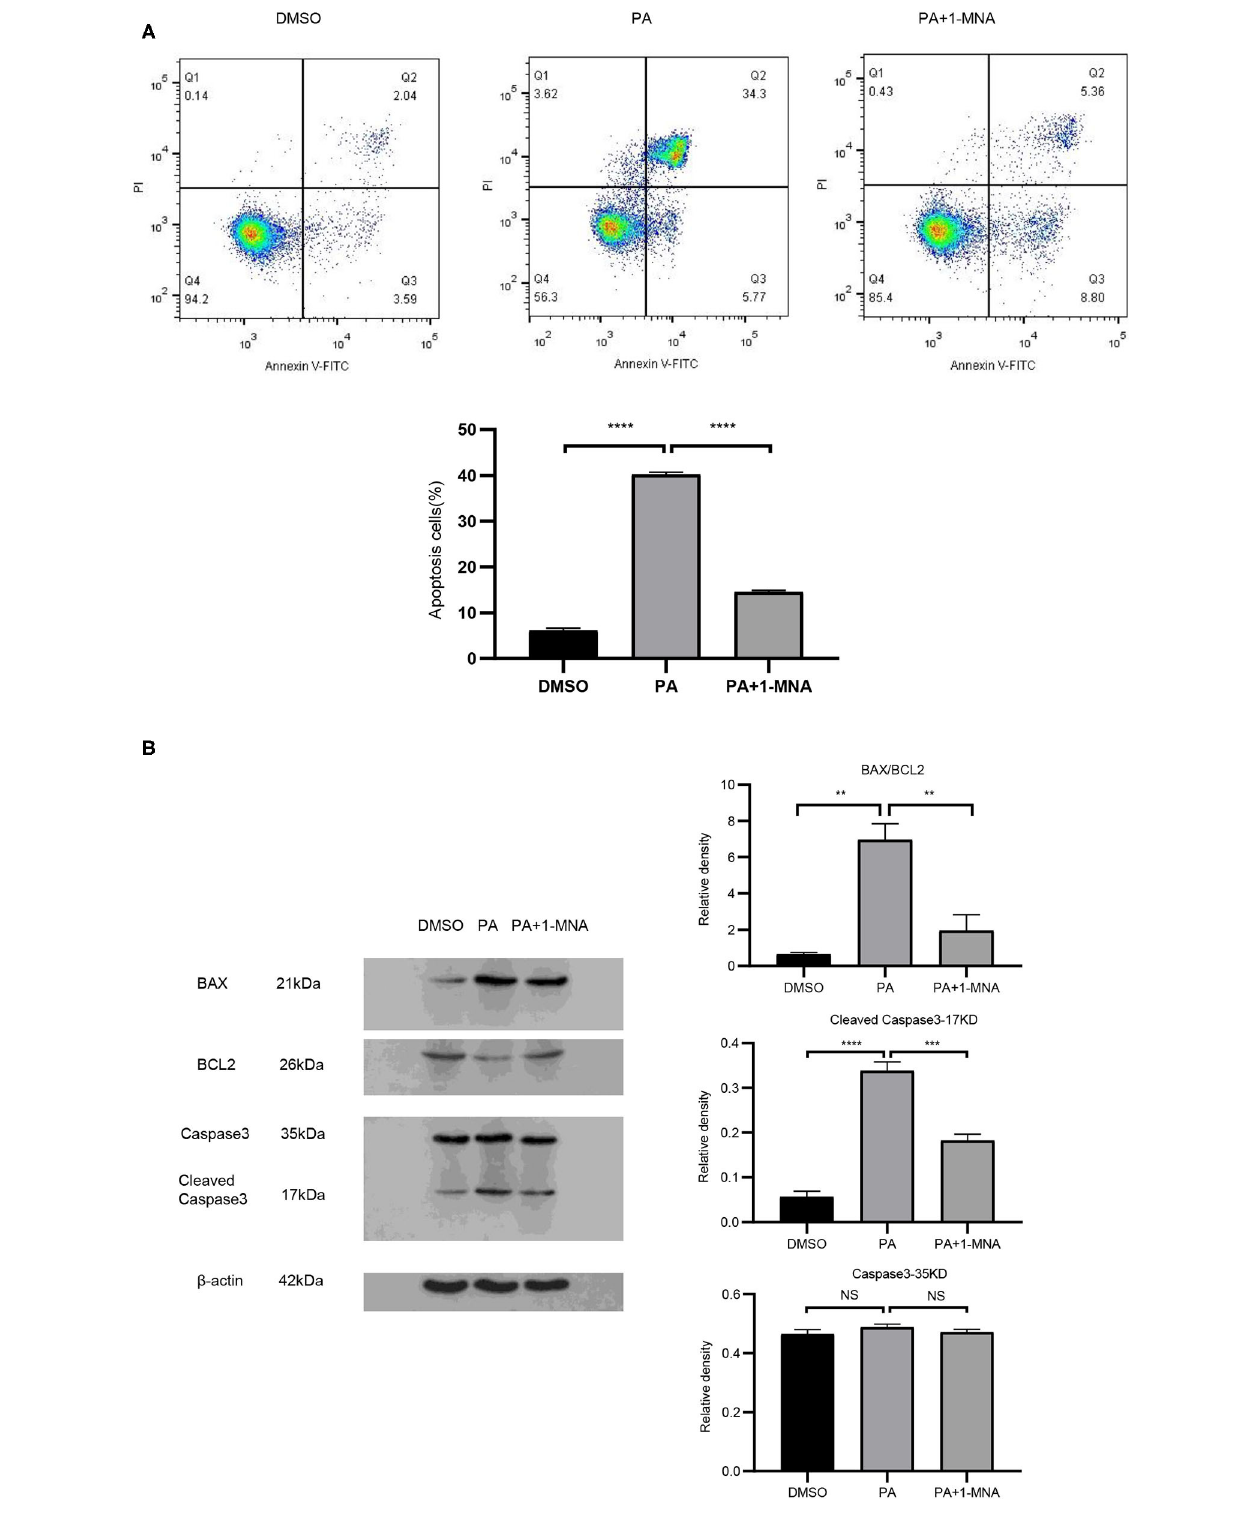
FIGURE 2 | 1-MNA inhibits apoptosis of PA-induced H9C2 cells. (A) Cell and nuclear images by flow cytometry analysis. Data are shown as mean ± SEM from three independent experiments. (B) Western blotting analysis of Caspase-3, Bax, and Bcl-2. The image of the gel shown is a representative picture. ( n = 3, NS = no significance, ** P < 0.01, *** P < 0.001, **** P < 0.0001).